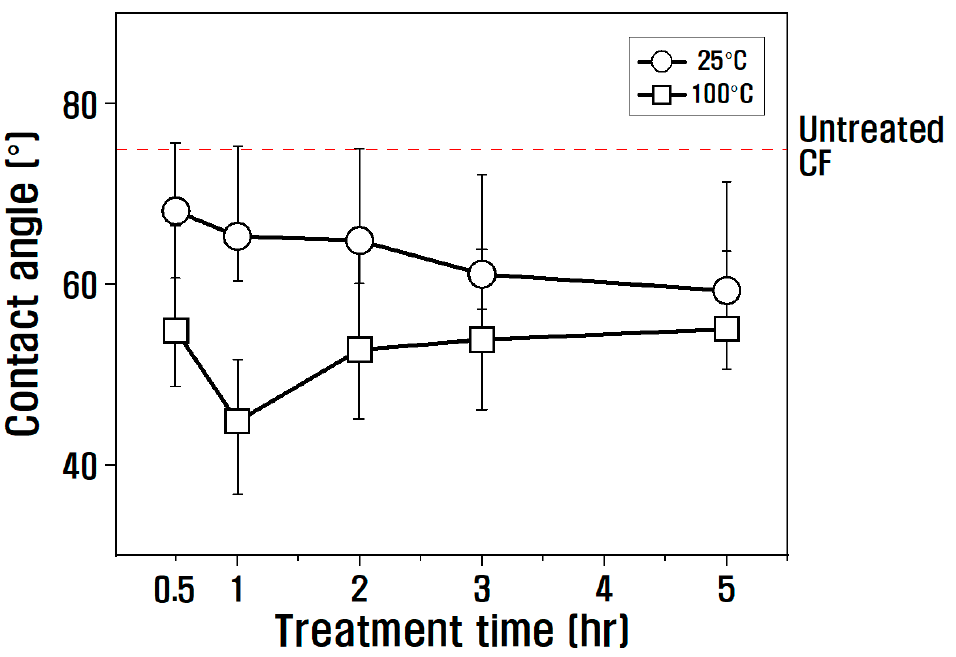
Figure 5. Relationship between contact angle and treatment time according to temperature.